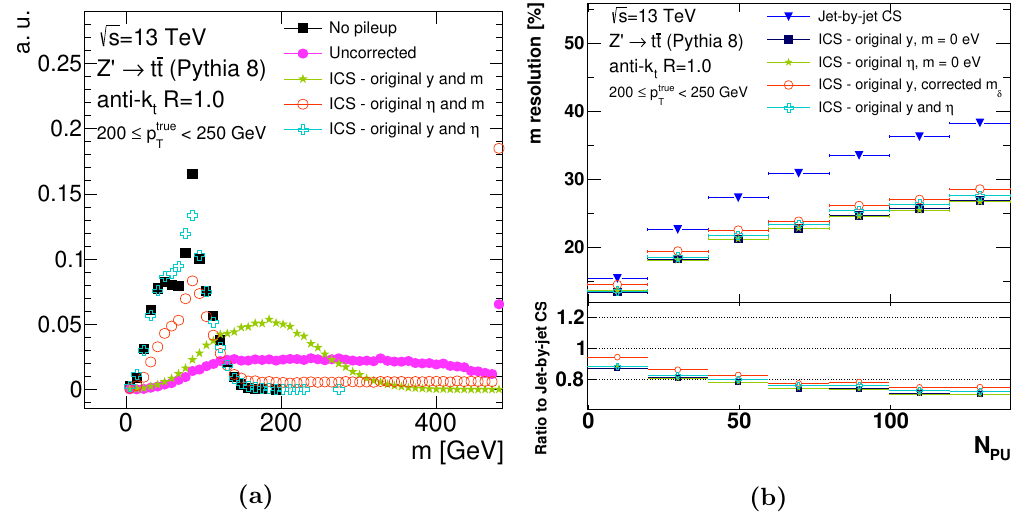
Figure 20. Jet mass distribution (left) for the true jets, jets with pileup, and ICS corrected jets for three di(cid:11)erent approaches for the treatment of massive inputs: two approaches in which the particle mass is unchanged and one approach in which the rapidity and pseudo-rapidity is kept